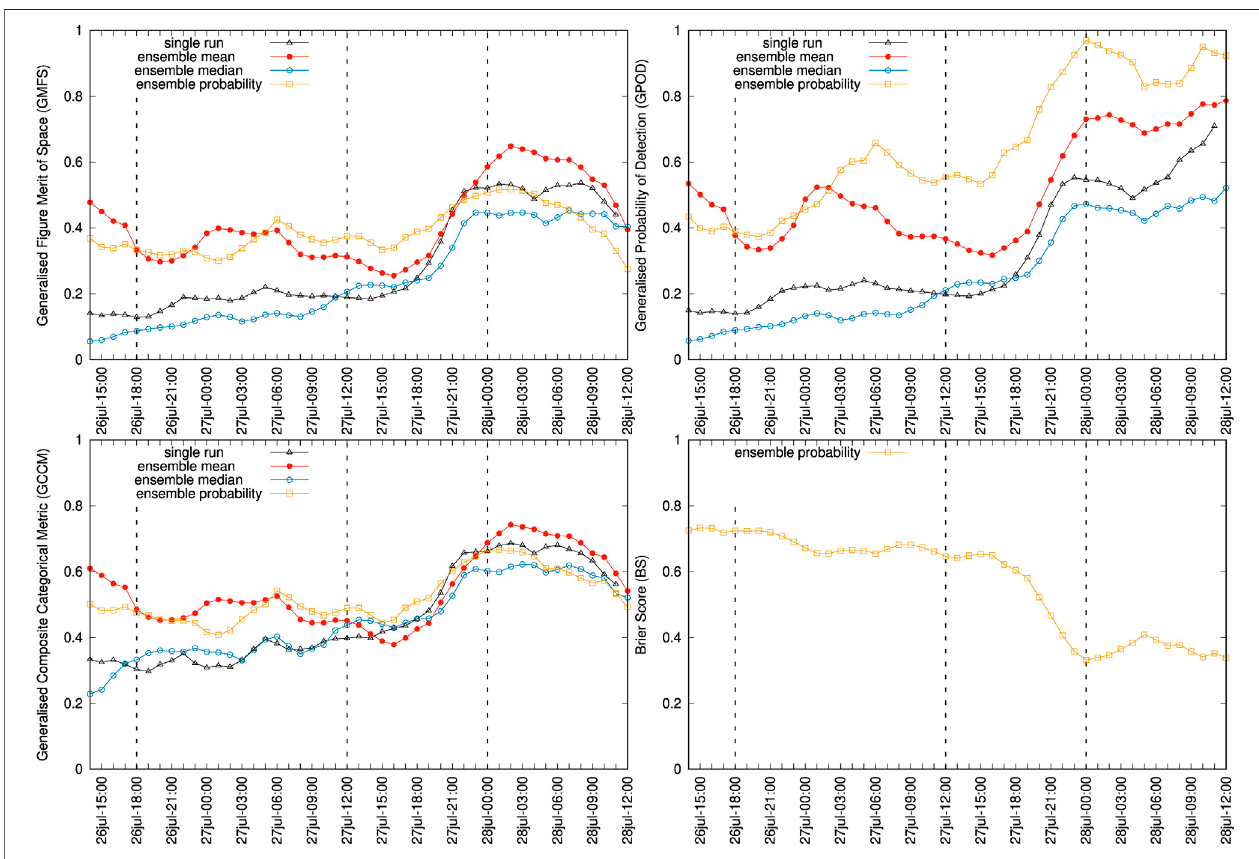
FIGURE 4 | Time series of generalised categorical metrics for deterministic (single run and ensemble-based) and probabilistic Ambae forecasts using the 20 DU SO 2 column mass contours. Plots show GFMS (top left) , GPOD (top right) , GCCM (bottom left) and BS (bottom right) . Symbols indicate the instants of the AHI retrievals. The three vertical dashed lines mark the instants of the snapshots shown in Figure 3 . Note that for the BS only the probabilistic option applies.